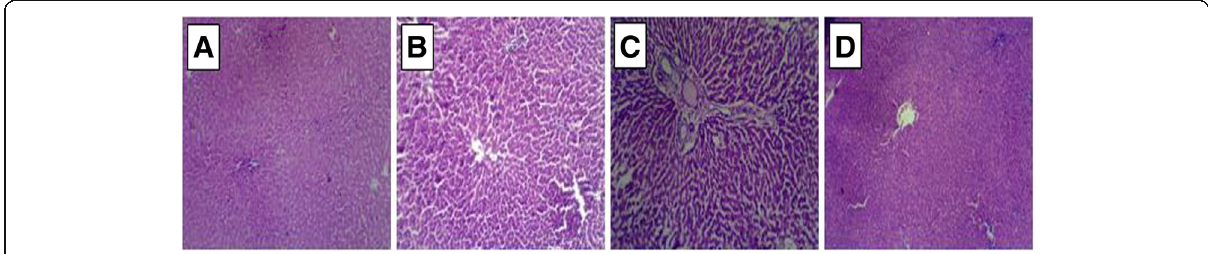
Fig. 10 Histopathological analysis of liver tissue in various concentration. a : Control group, b : Low dose (300 mg/kg), c : Mild dose (600 mg/kg), d : High dose (1200